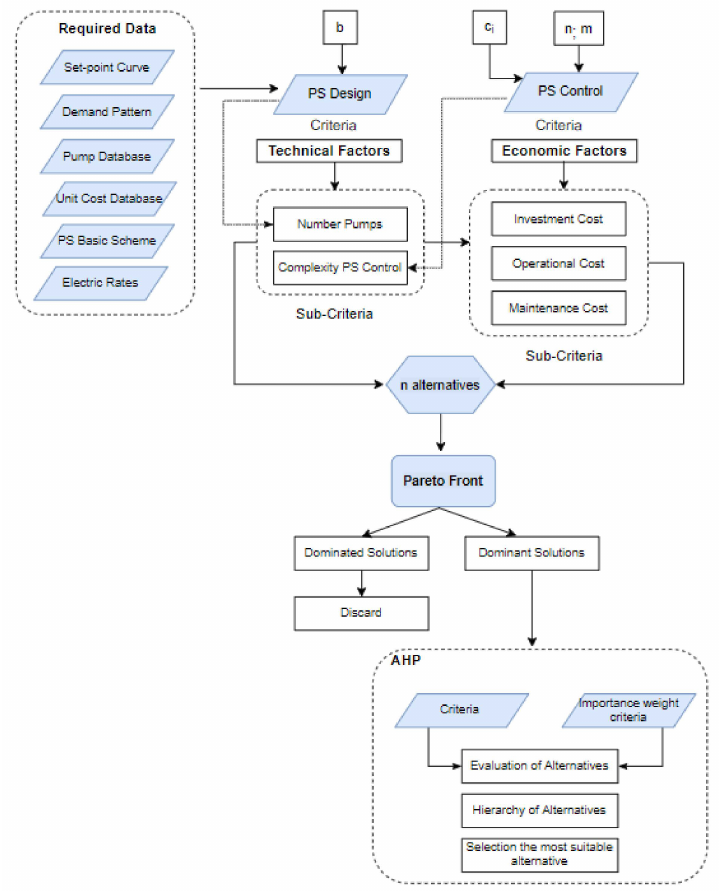
Figure 2. Flowchart of the proposed